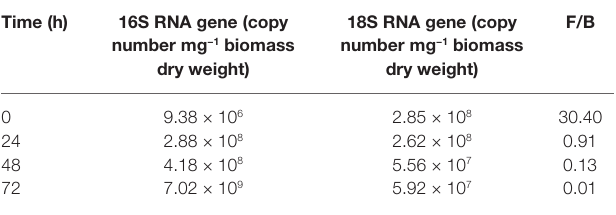
TABLE 1 | q-PCR quantification of bacterial (B) and fungal (F) gene copy number in mixed biofilm and their relative ratios at different incubation times. Time (h) 16S RNA gene (copy number mg −1 biomass dry weight)